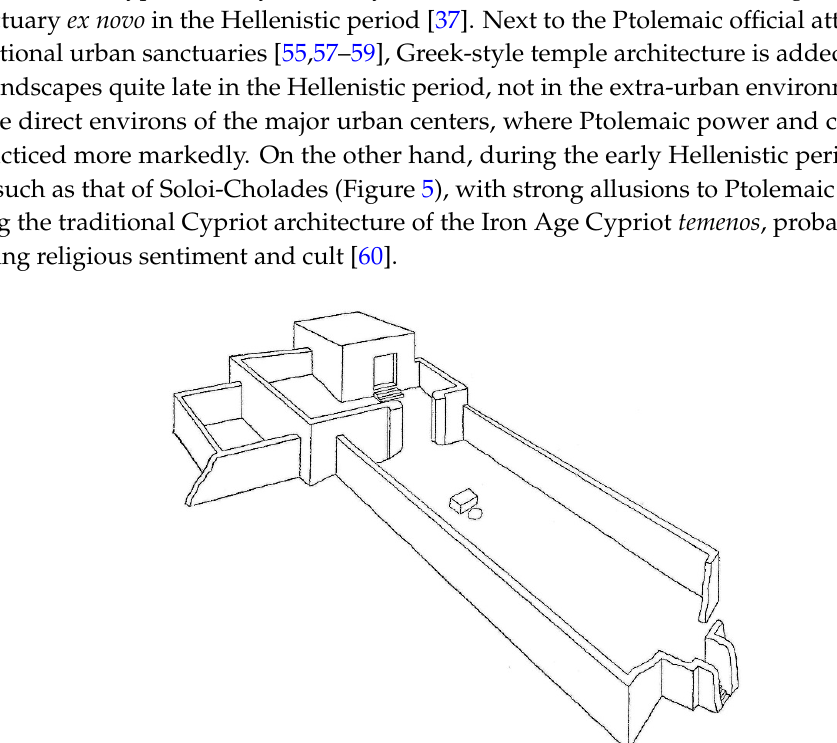
Figure 5. Soloi-Cholades sanctuary, reconstruction sketch of Hellenistic temple A [37].